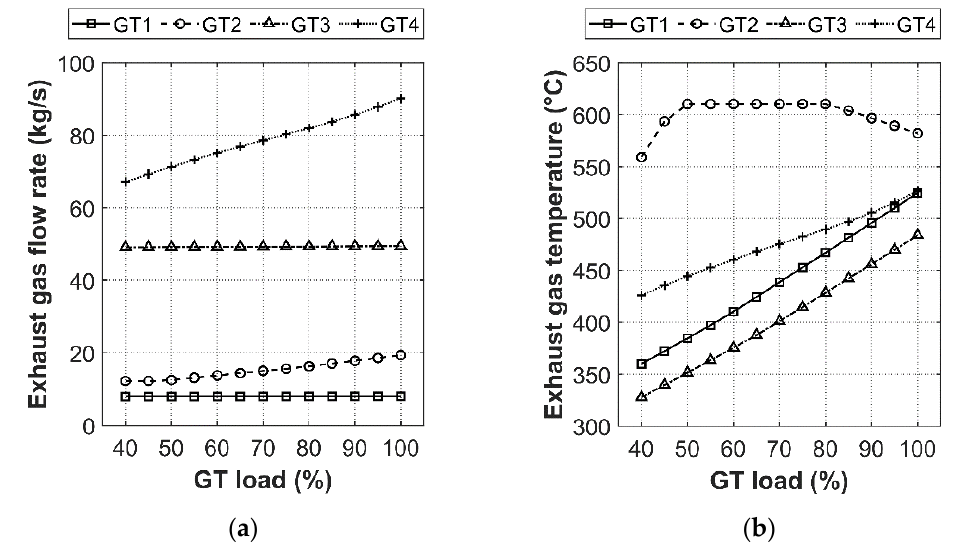
Figure 4. Gas turbines’ part-load operation: ( a ) exhaust gas flow rate; ( b ) exhaust gas temperature.